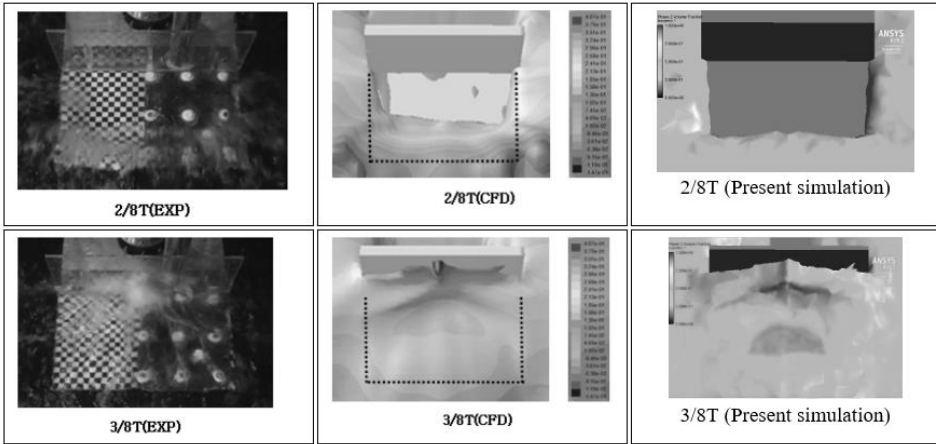
Figure 14. Comparisons of greenwater behaviours on the deck at various time instants: experiment ( column 1 ) and CFD ( column 2 ) from [19] vs. present simulation ( column 3 ) results.